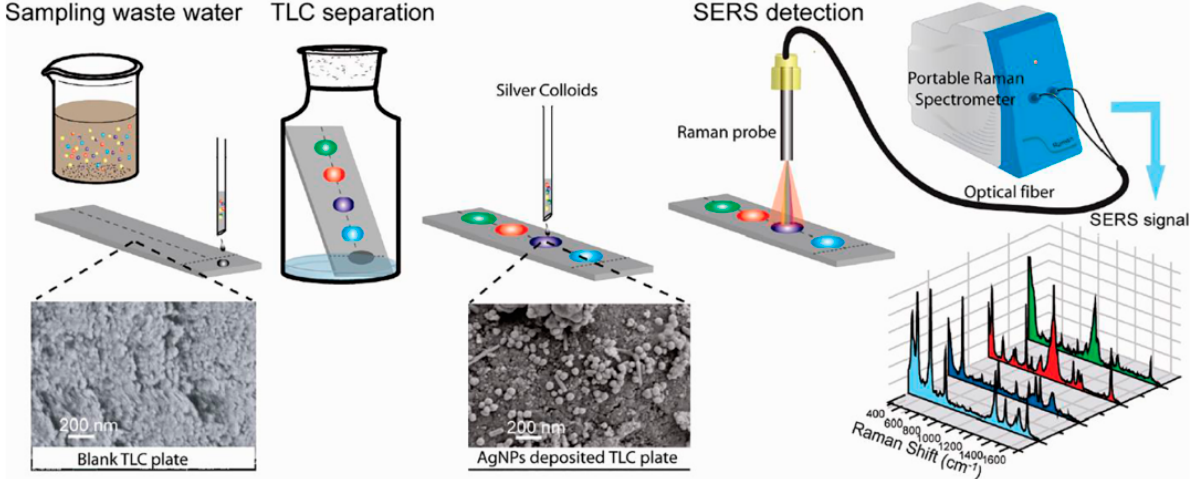
Figure 2. On-site detecting of organic pollutants from wastewater by TLC-SERS. Reprinted with permission from ref. [14]; Copyright 2011 American Chemical Society.